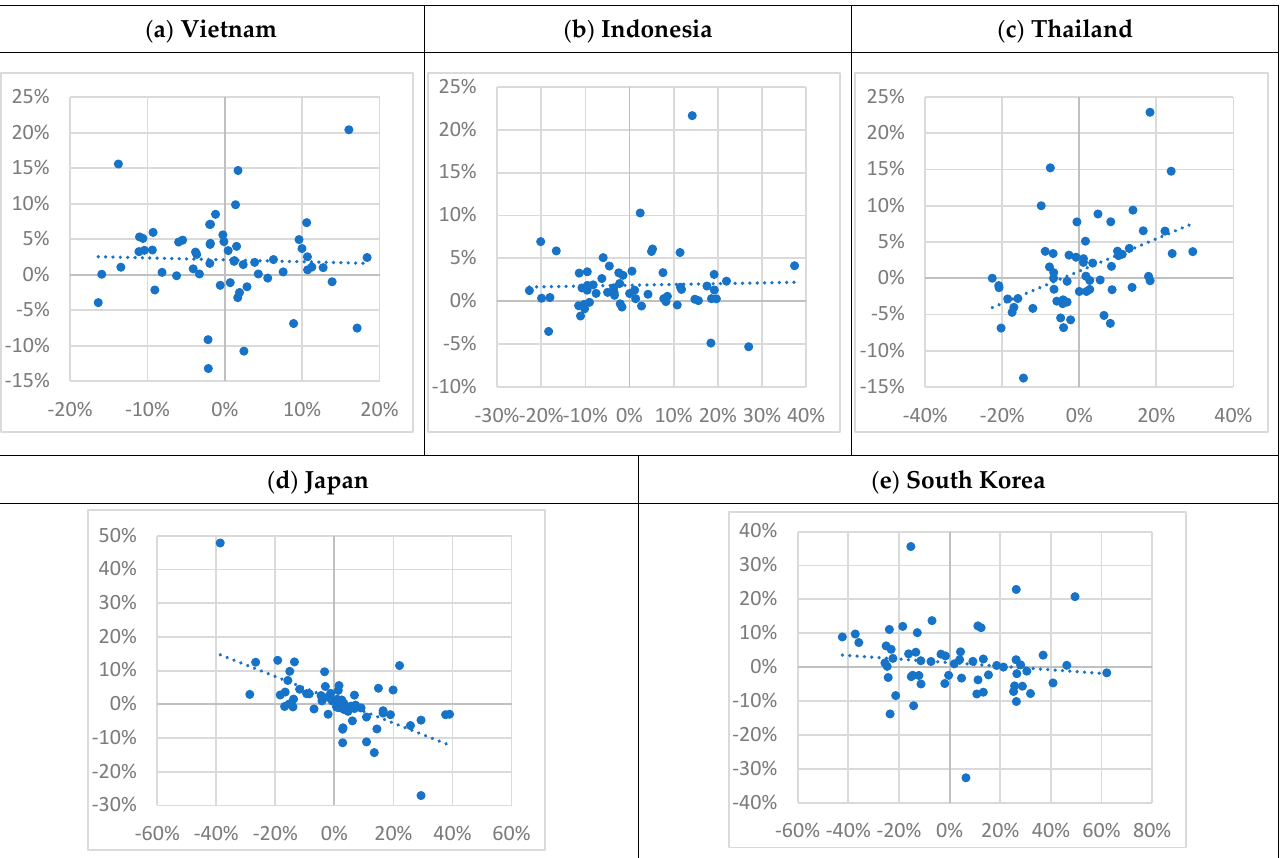
Figure 11. Relationship between changes in annual precipitation and changes in annual rice yield in ( a ) Vietnam, ( b ) Indonesia, ( c ) Thailand, ( d ) Japan, and ( e ) South Korea. These data range from 1961 to 2020. The X-axis represents the precipitation change (%), and the Y-axis represents the yield change (%). (Source: data retrieved from [4,84]).